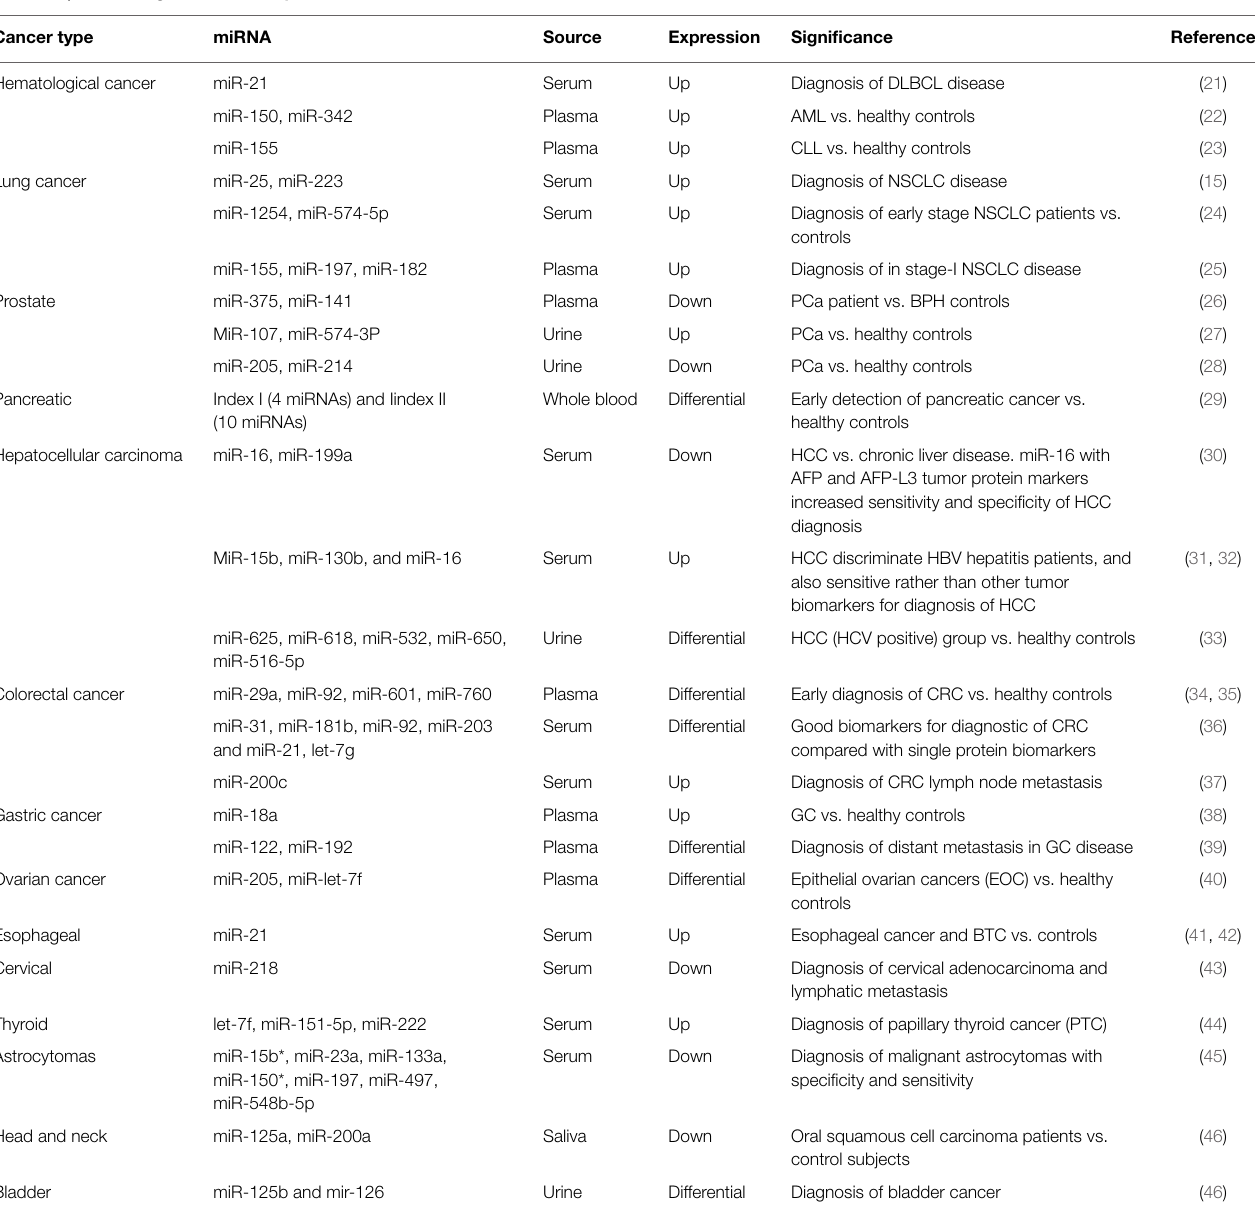
TABLE 1 | Circulating microRNAs a potential biomarkers in human cancers